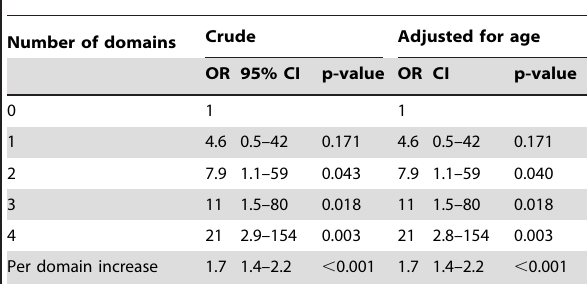
Table 2. Risk of older persons to be dissatisfied with GP care related to complexity of health problems, with adjustment for age.